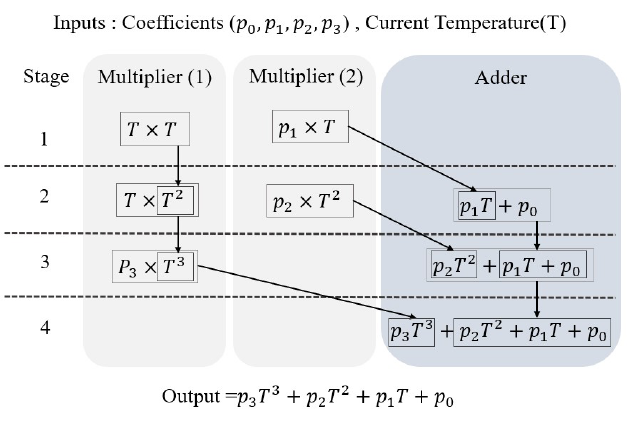
Figure 7. Operation flow of the V opt